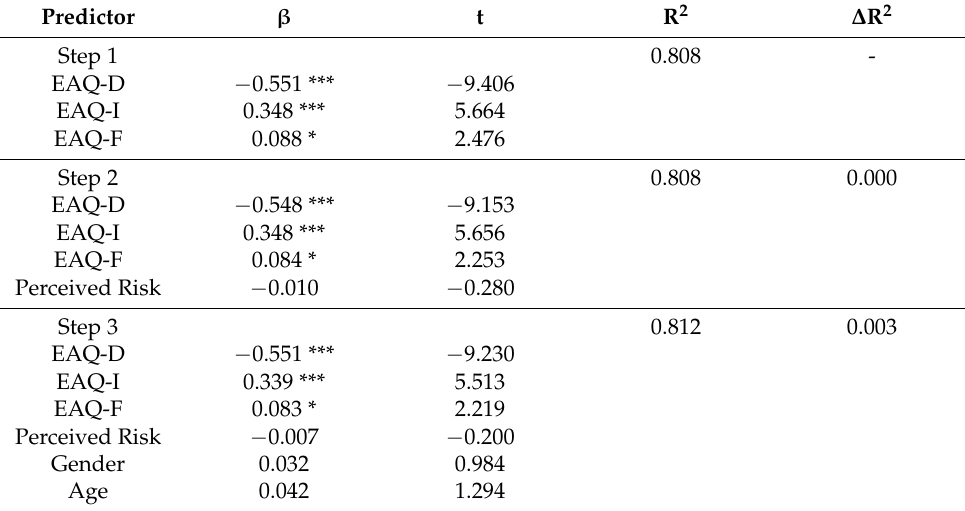
Table 4. Stepwise regression model of the intention to engage in direct entomophagy ( n =